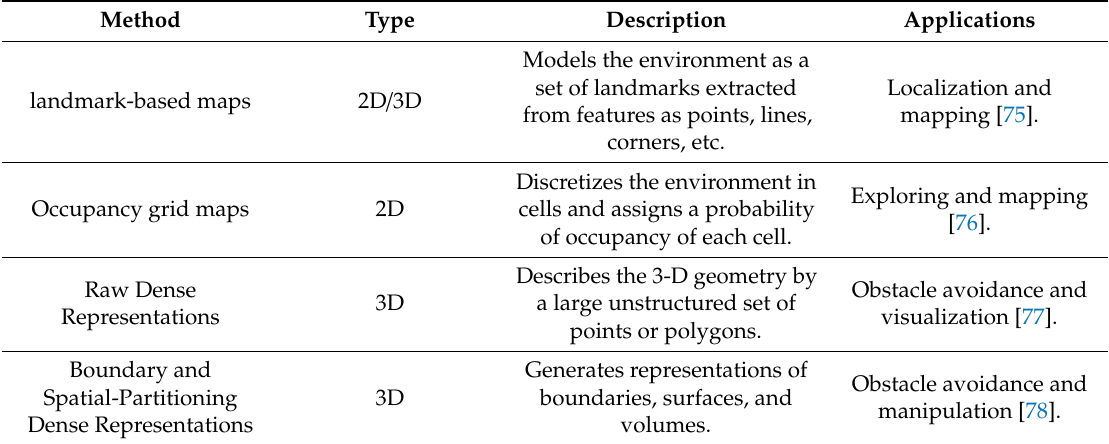
Table 3. SLAM representation methods.